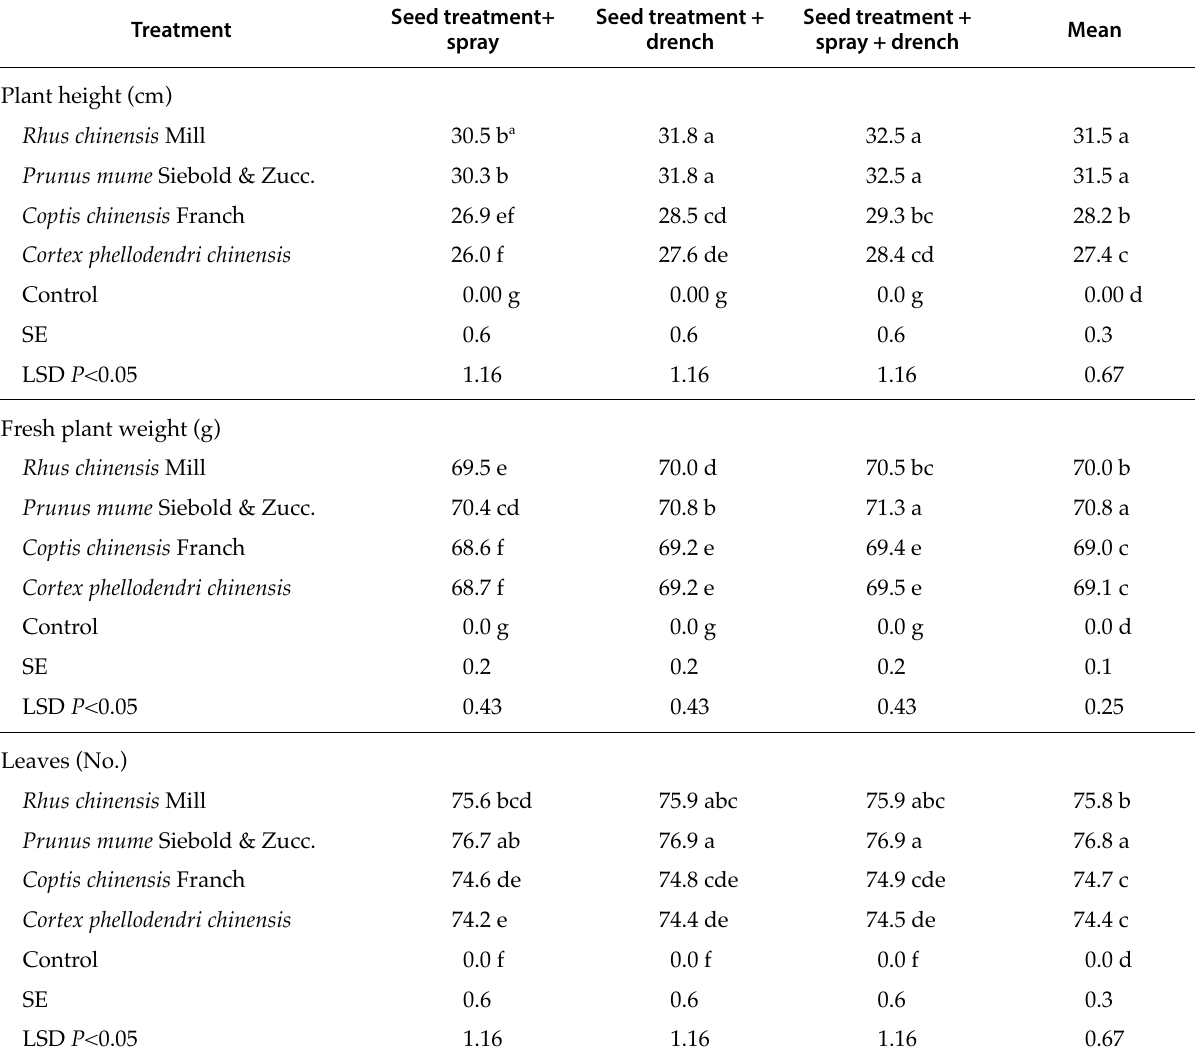
Table 4. Influence (percent increases over experimental controls) of four Chinese medicinal herbs (applied with three dif - ferent treatment methods) on plant growth under greenhouse conditions. Control was inoculated but